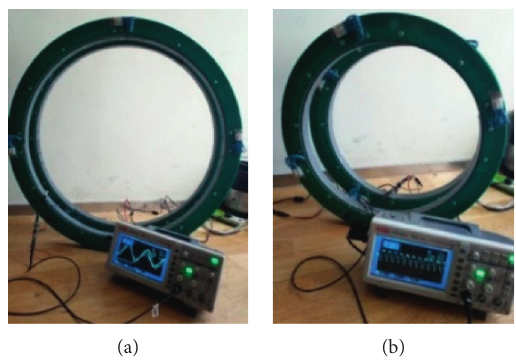
Figure 7: Experimental device setup photos. (a) Coil diameter 700mm. (b) Coil diameter